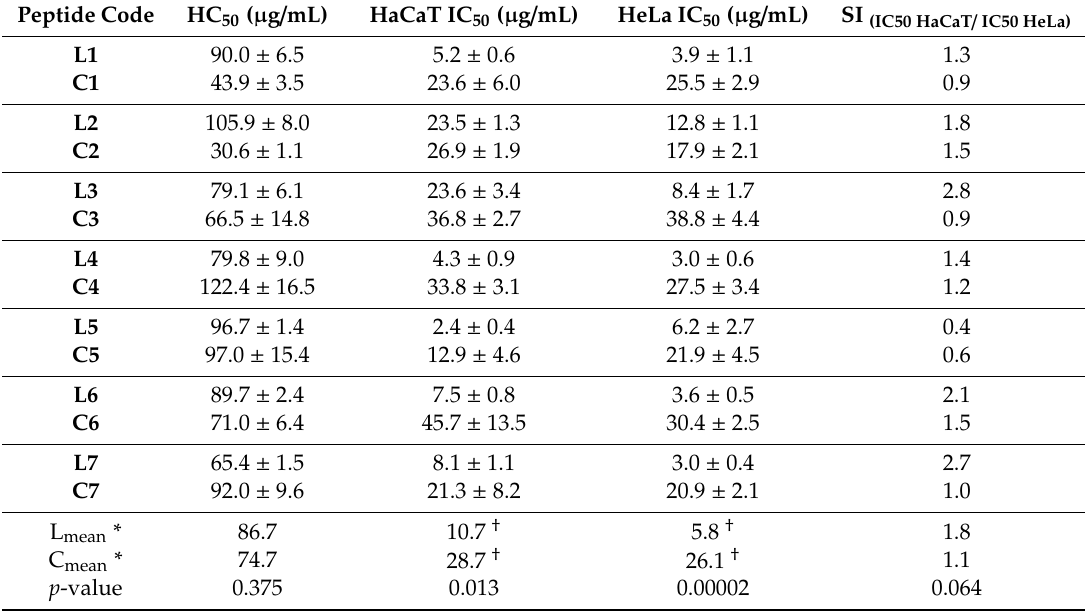
Table 5. Hemolytic activity (HC50) and cytotoxicity (IC50) to HaCaT and HeLa. Peptide